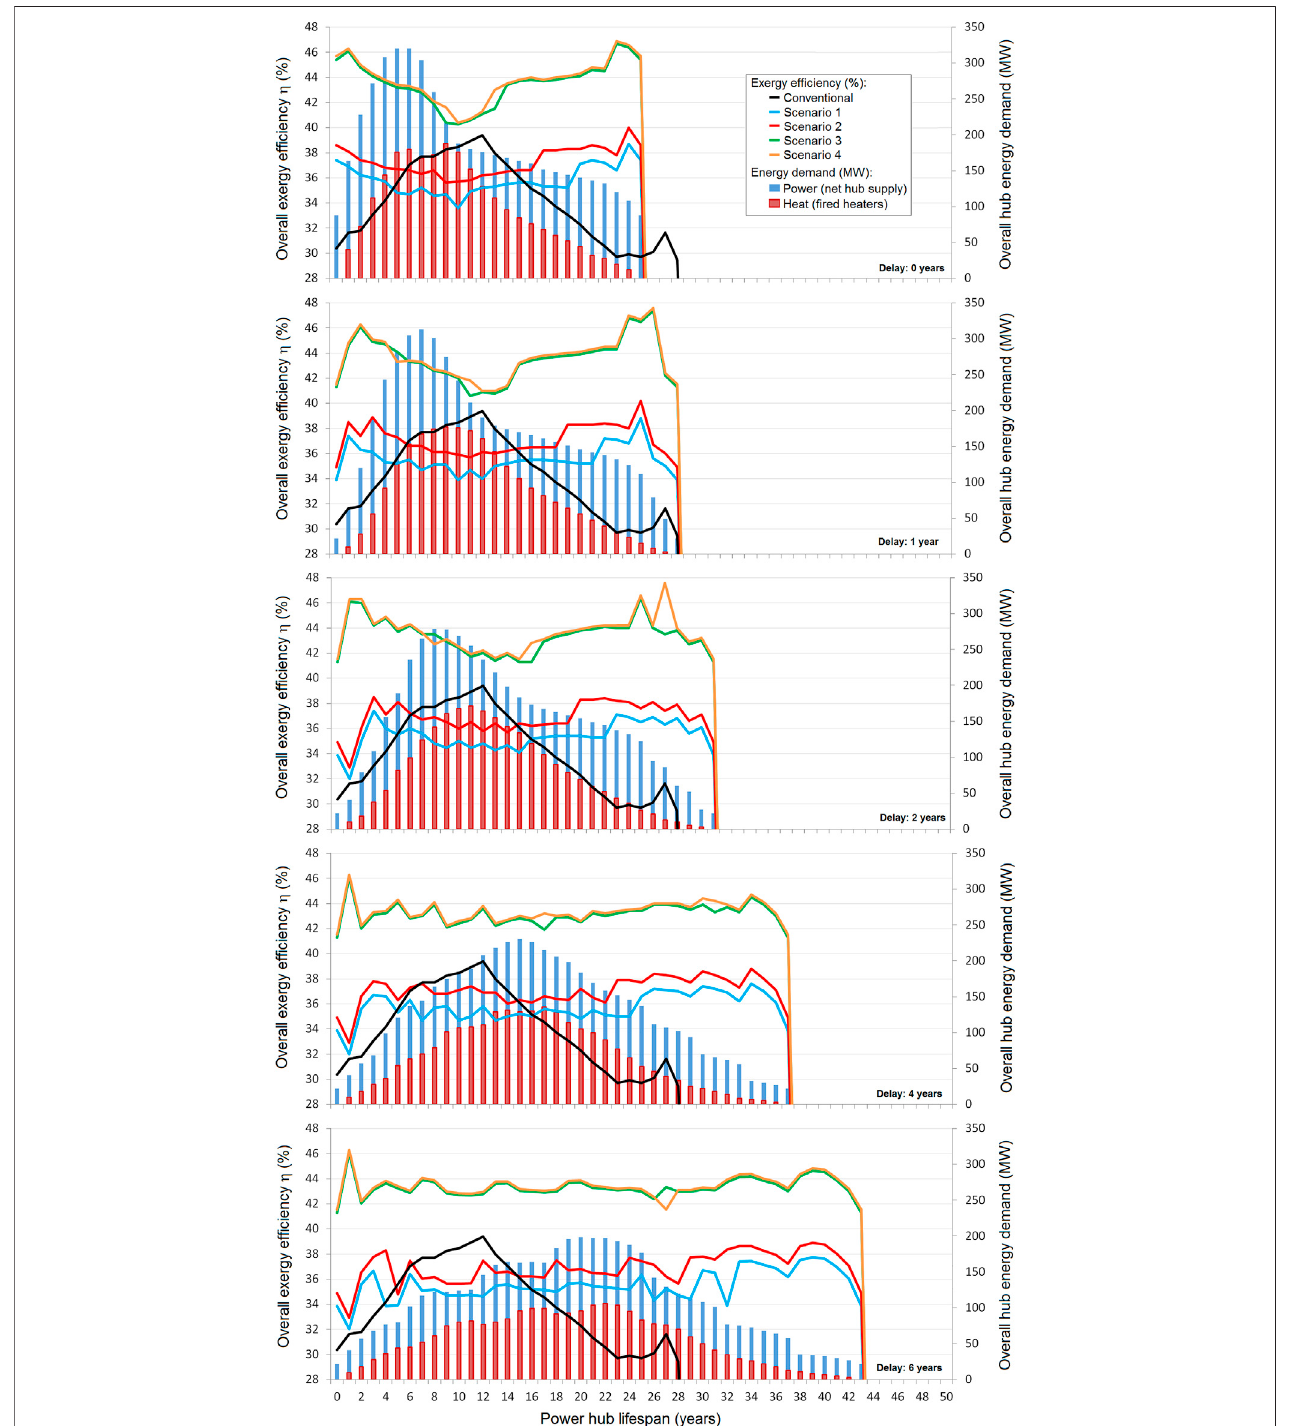
FIGURE 6 | Yearly exergy ef fi ciency of the utility systems as a function of the delay in entrance of operation. Overall hub energy demands are also shown.